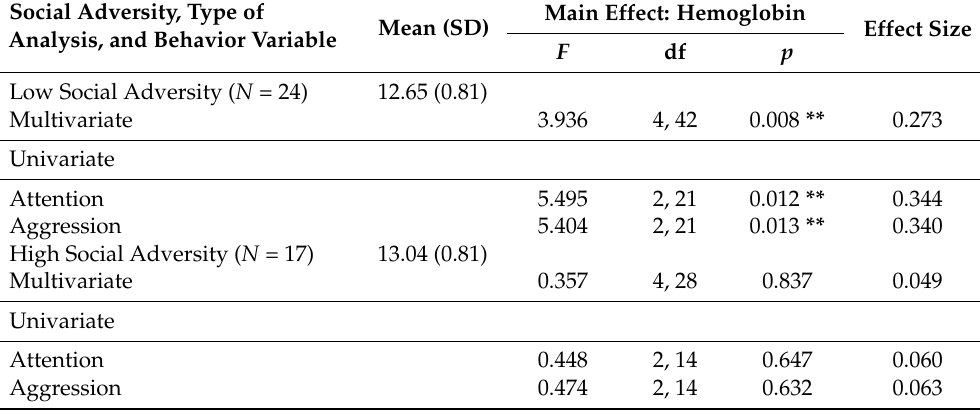
Table 5. Social adversity-stratified a results of univariate and multivariate analysis of variance b of the effect of hemoglobin levels c at age 4 on girls’ externalizing behavior at age